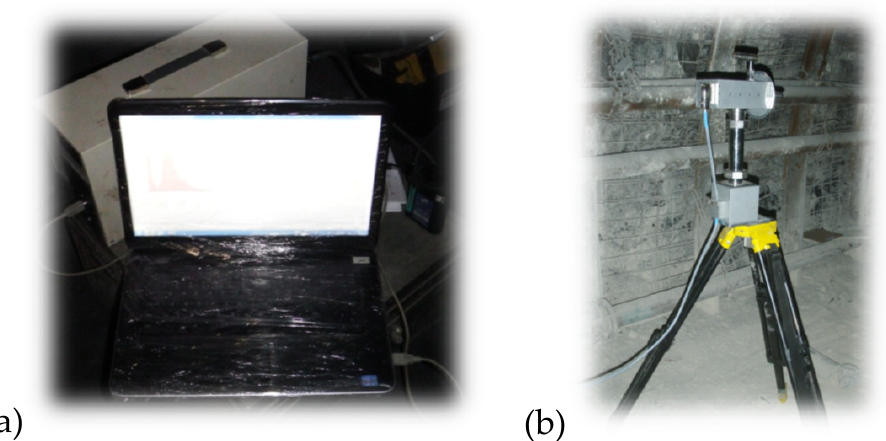
Figure 5. IPSQ analyzer, consisting of: ( a ) electronic measuring block with a computer; ( b ) measuring probe.